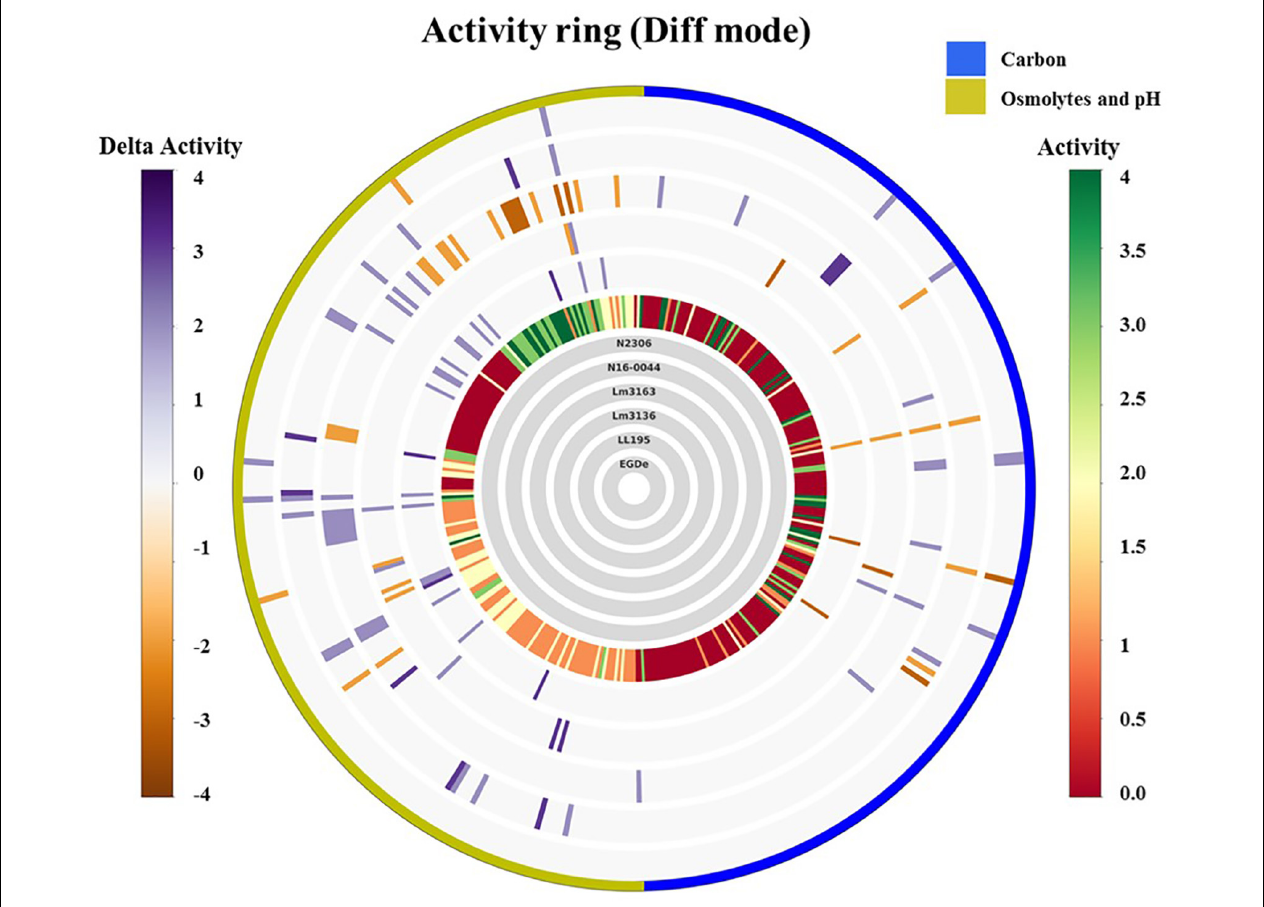
FIGURE 1 | Overall growth/metabolic activity ring based on phenotype microarray comparison of the strains with respect to C-source utilization (PM01 and PM02) and stress (osmolytes and pH; PM09 and PM10) resistance: gray inner circles indicate the strains’ order; external circle indicates the PM categories. The activity index (AV) calculated for each strain and well is reported as color stripes going from red (AV = 0) to green (AV = 4). Delta activity: the difference with the AV value of the reference strain is reported when equal to or higher than 2 AV; gray is no difference; purple indicates a higher activity; orange color indicates a lower activity.